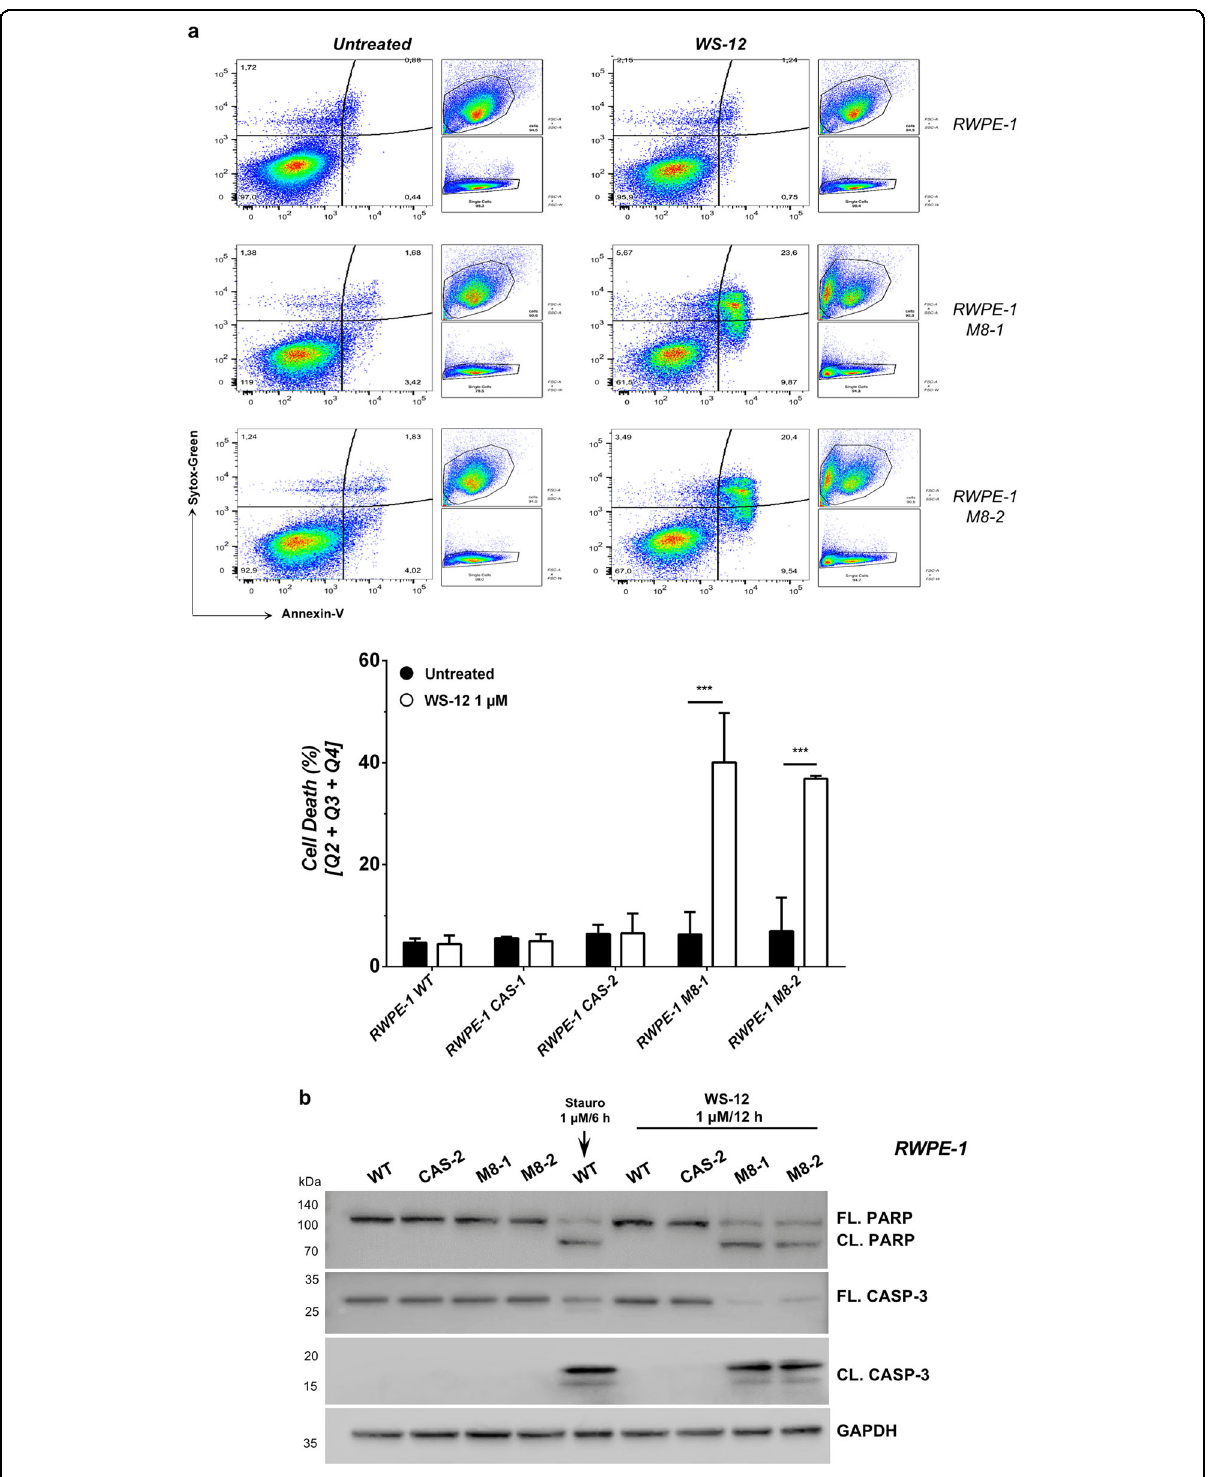
Fig. 4 RWPE-1 response to TRPM8 agonist WS-12. a Cell death response by FACS (Annexin-V; Sytox-Green) in RWPE-1 cells expressing endogenous, increased (M8) or knocked-out (CAS) TRPM8 levels following 12 h WS-12 (1 μ M) administration. Quanti fi cation is reported as percentage of total cells (lower panel). b Western blotting analysis showing molecular signature of apoptotic cell death (Caspase-3 and PARP cleavage). Staurosporine was used as positive control. Error bars, mean ± SD. Experiments were performed in triplicate; data were analyzed using a two-tailed Student ’ s t -test. *** P ≤